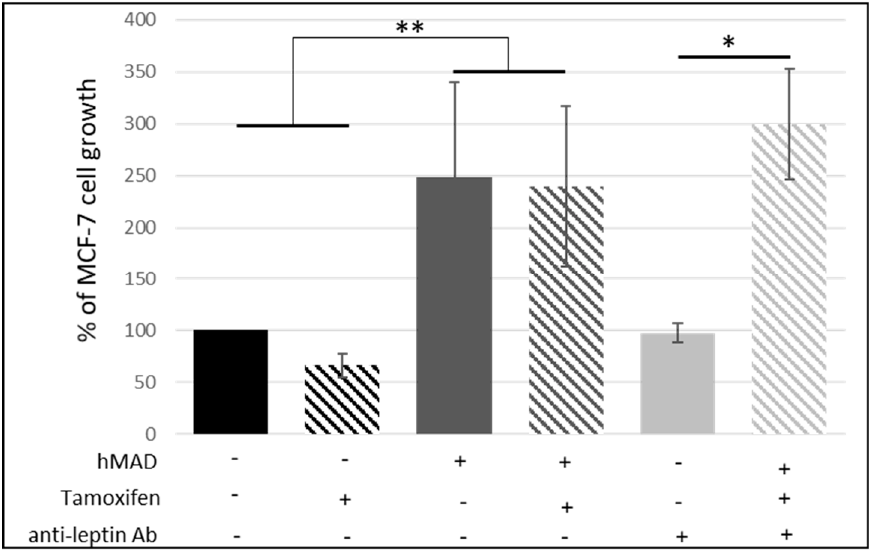
Figure 6. Influence of leptin on anti-estrogen resistance. Percentage of MCF-7 cell growth treated with tamoxifen and anti-leptin antibody (Percentage of growth ± SEM, n = 3, * p < 0.05, ** p < 0.01).